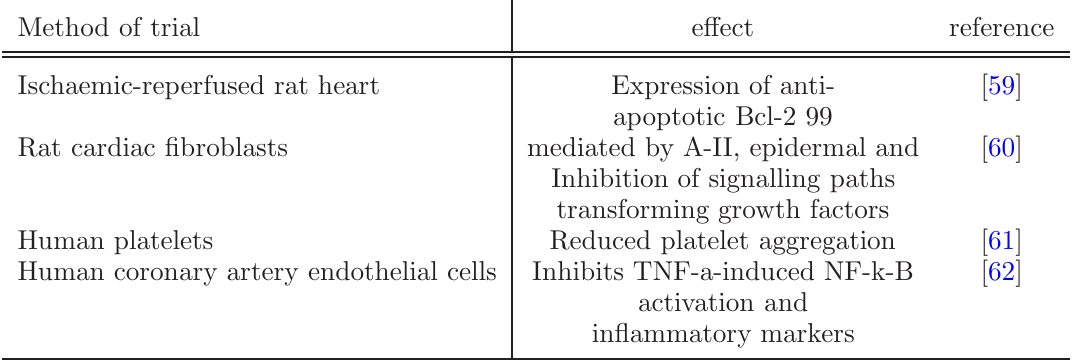
Table 1 Cardiovascular effects of resveratrol on isolated tissues or